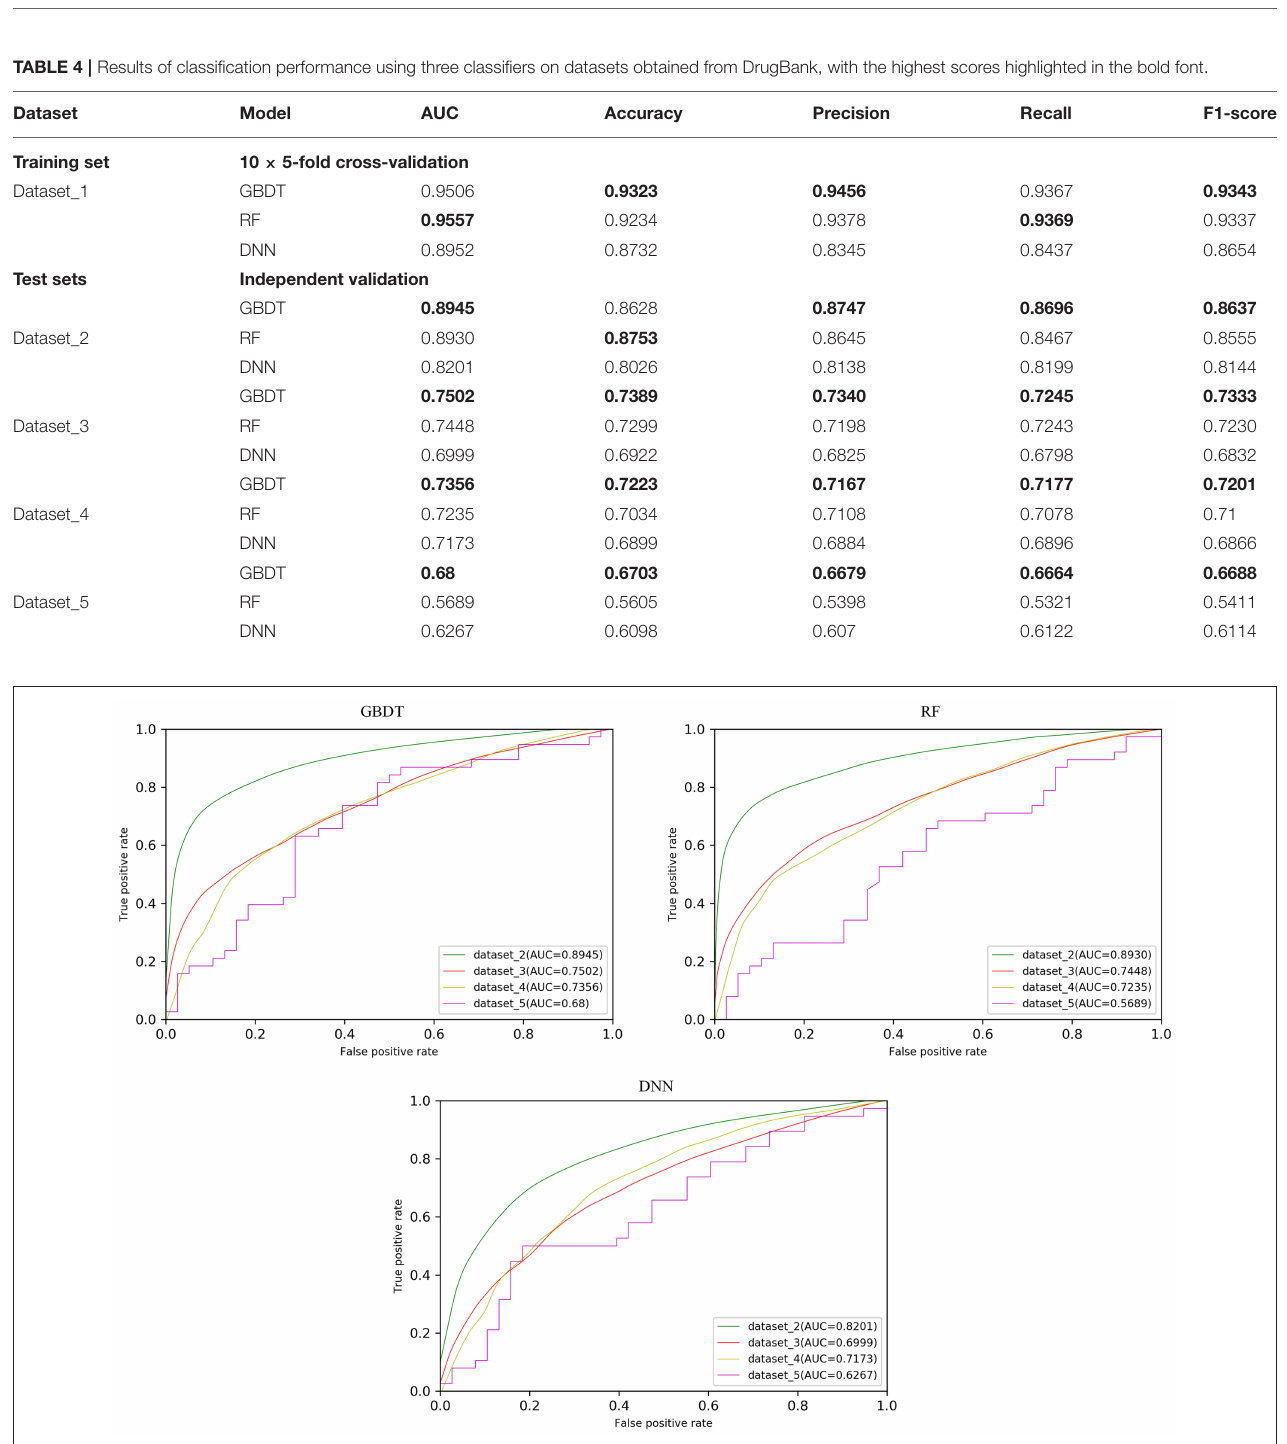
FIGURE 4 | ROC curves with different models on the test sets obtained from